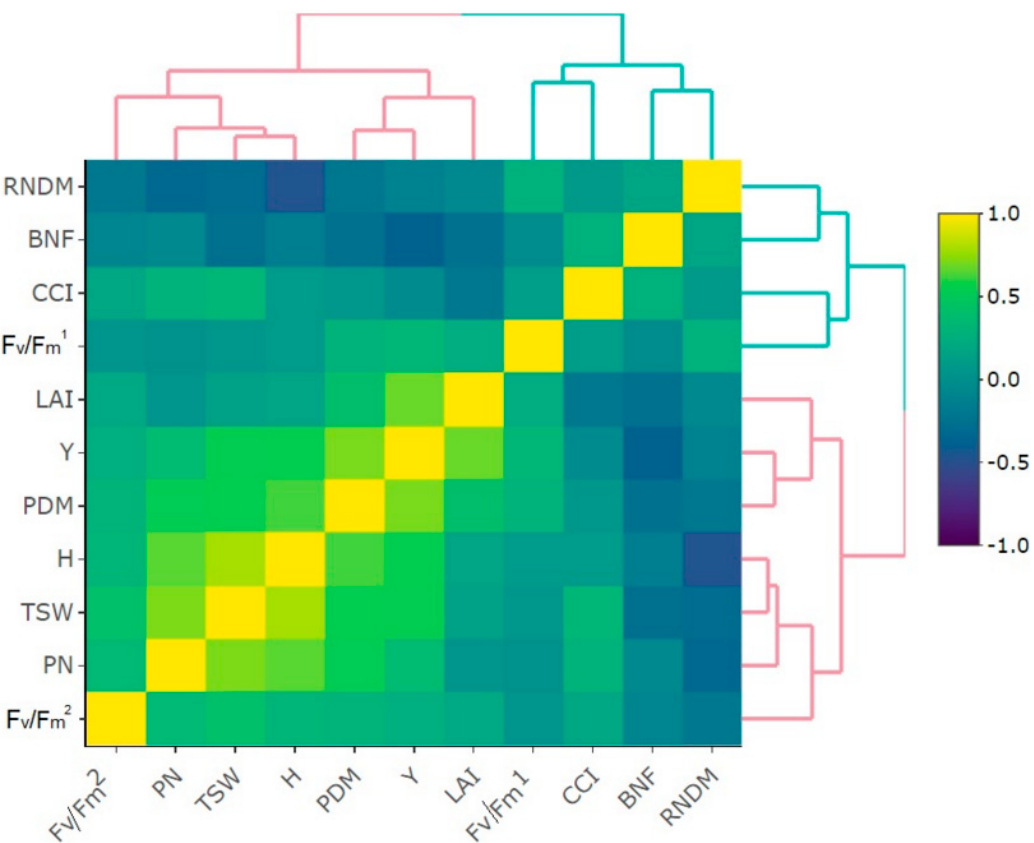
Figure 3. Correlations between all biometric and physiological characteristics of white lupine plants.